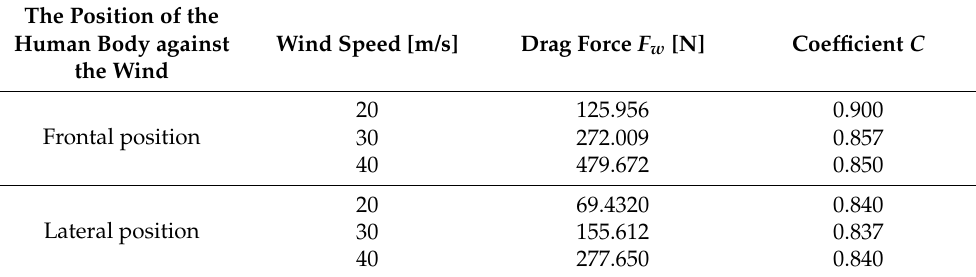
Table 8. The values of the drag force acting on the human body according to [59].